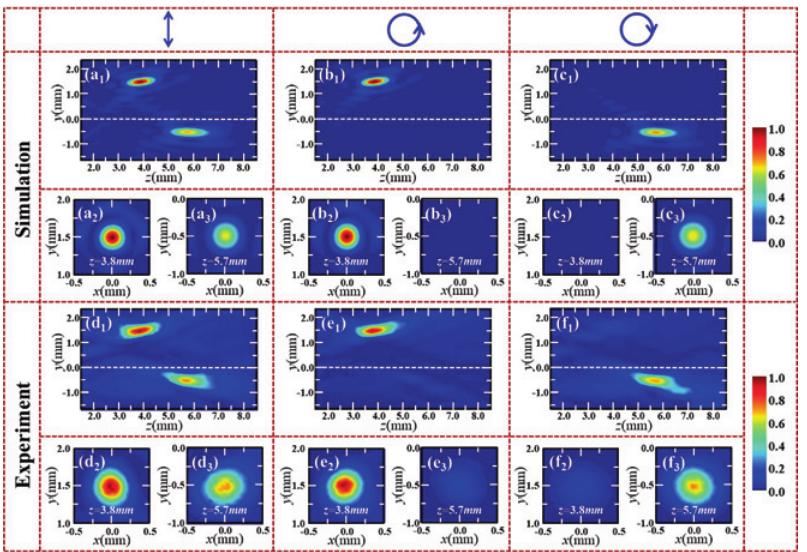
THz waves. (d 1 ∼ f 3 ) The